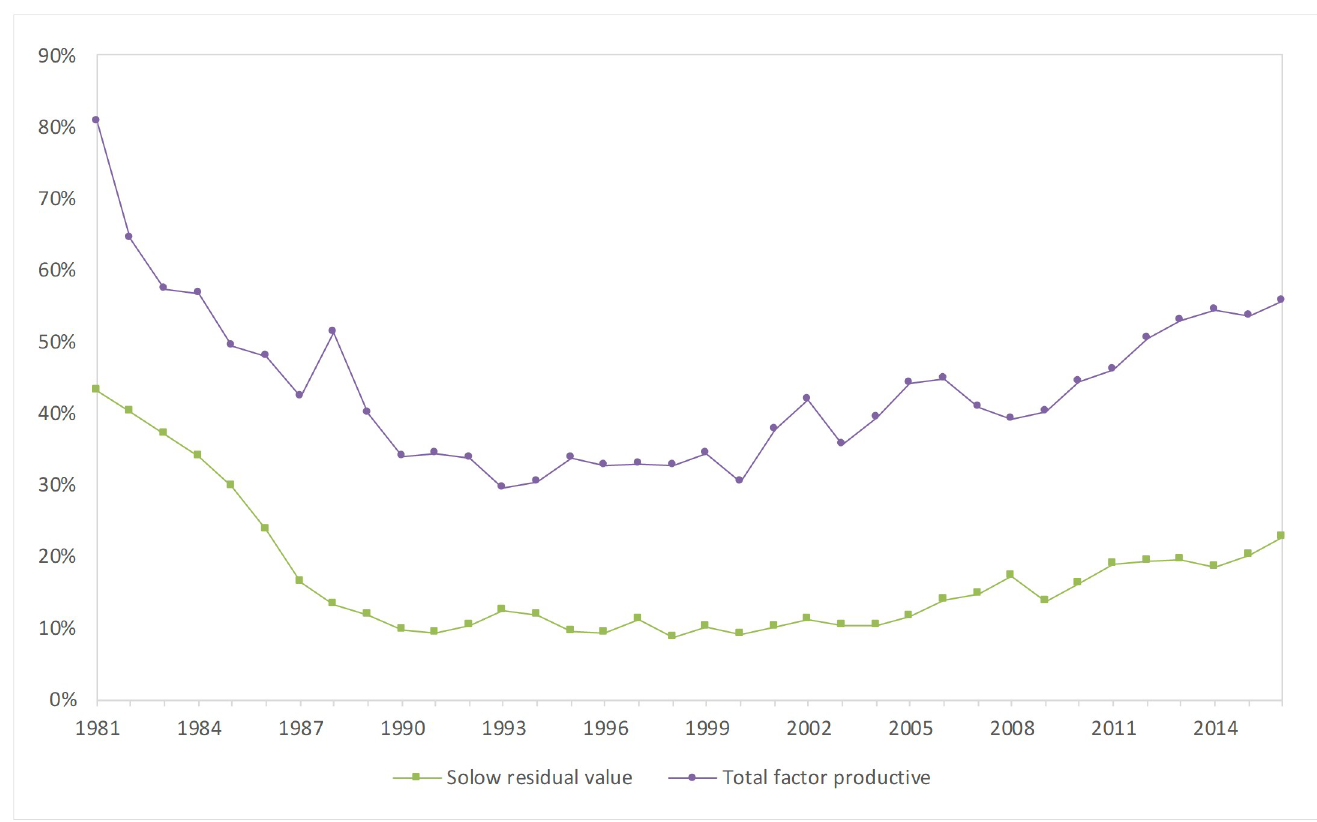
Fig 3. Trend of the contribution rate of scientific and technological